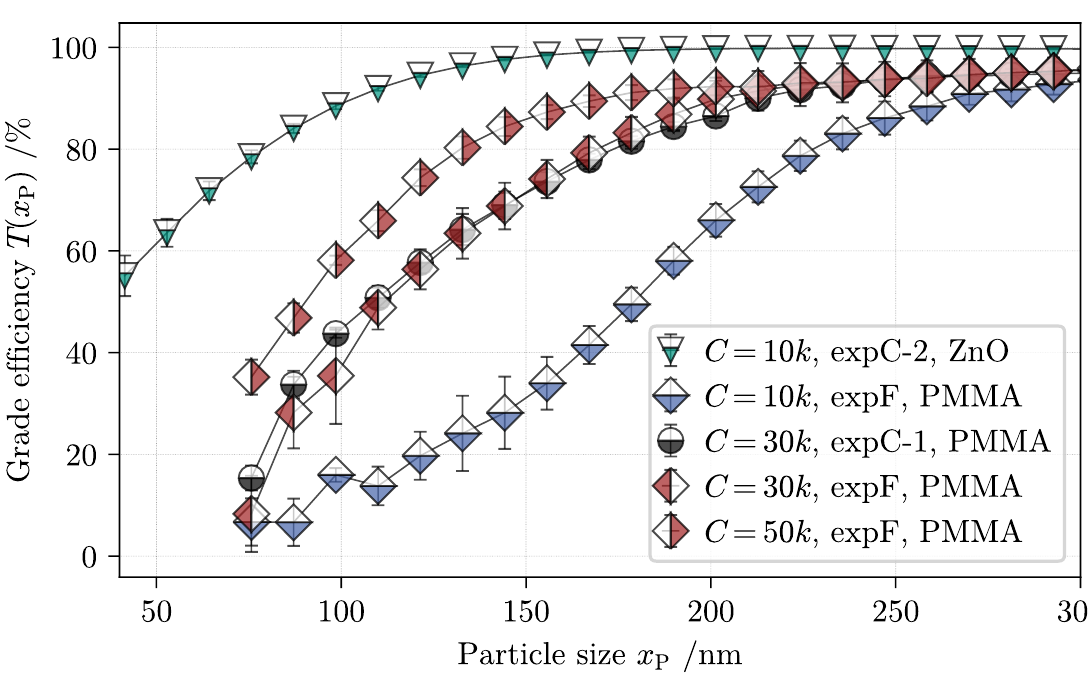
Figure 10. Summary of grade efficiency plots for PMMA after fractionation at three C-values (diamonds) and classification at a constant rotor speed (circles). An additional classification run of a pure ZnO suspension at C = 10,000 yields the leftmost partition curve